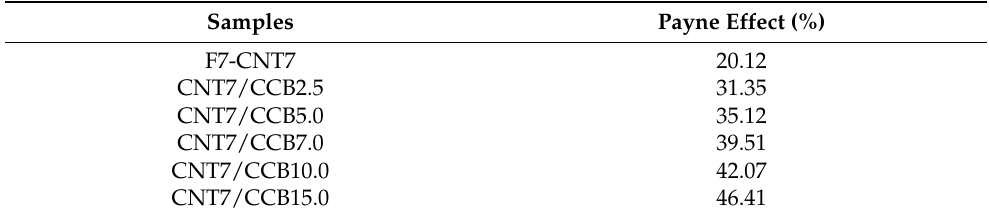
Table 4. Payne effect of ENR-50 compounded with FeCl 3 (ENR–FeCl 3 ) filled with CNTs (F7-CNT7) and CNT–CCB hybrid fillers with various loadings of